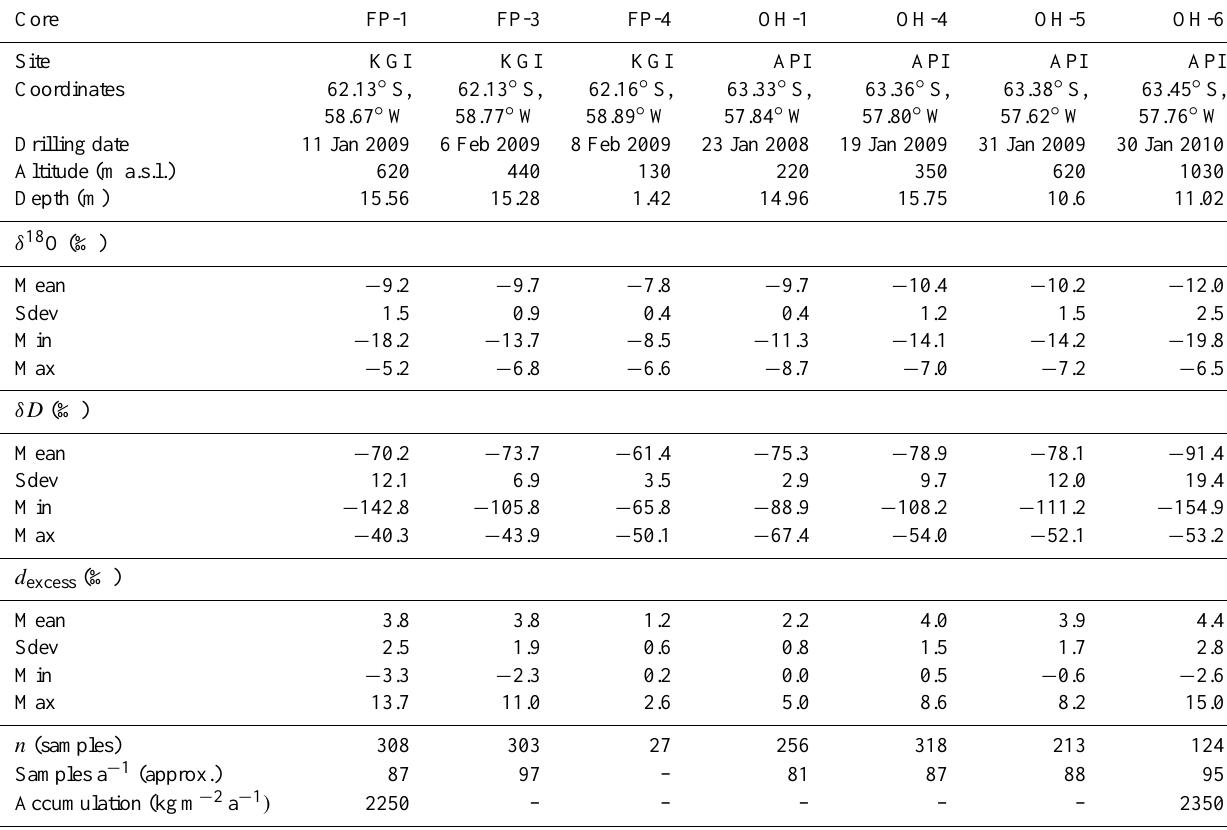
Table 1. Geographical location, mean isotope values and basic statistics of the high resolution (5cm) stable isotope analyses of all firn cores retrieved from King George Island (FP) and the northern Antarctic Peninsula